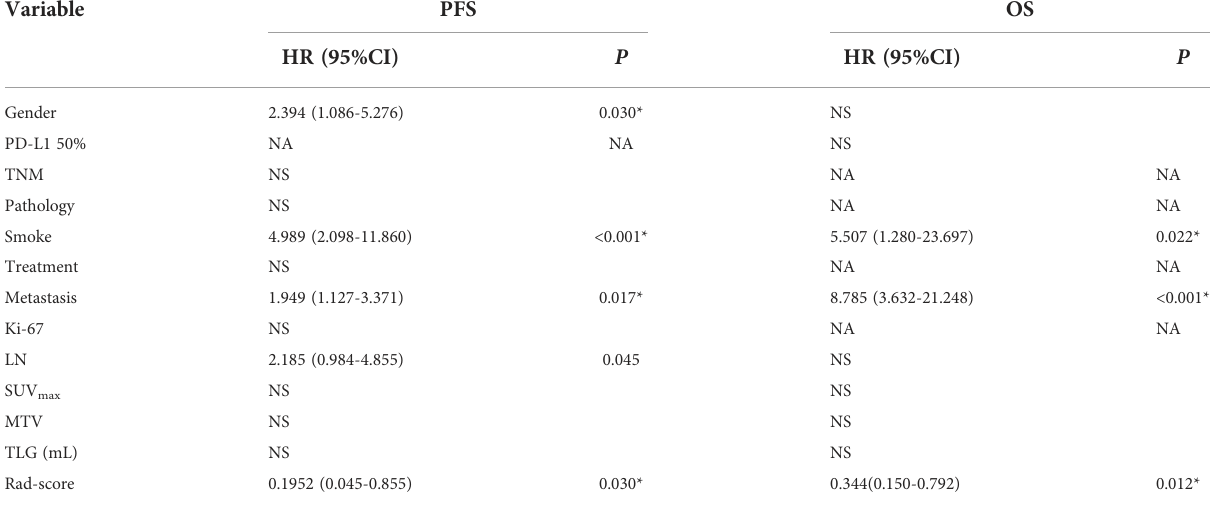
TABLE 3 The results of the multivariate Cox regression analysis.